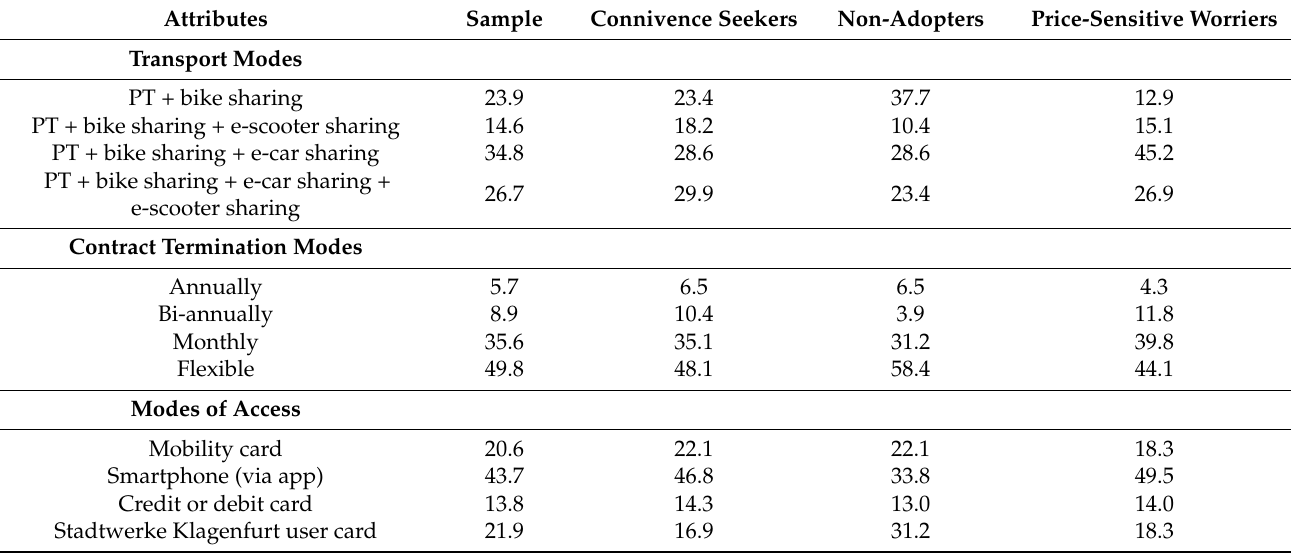
Table A7. Results of BYO exercise (% of the